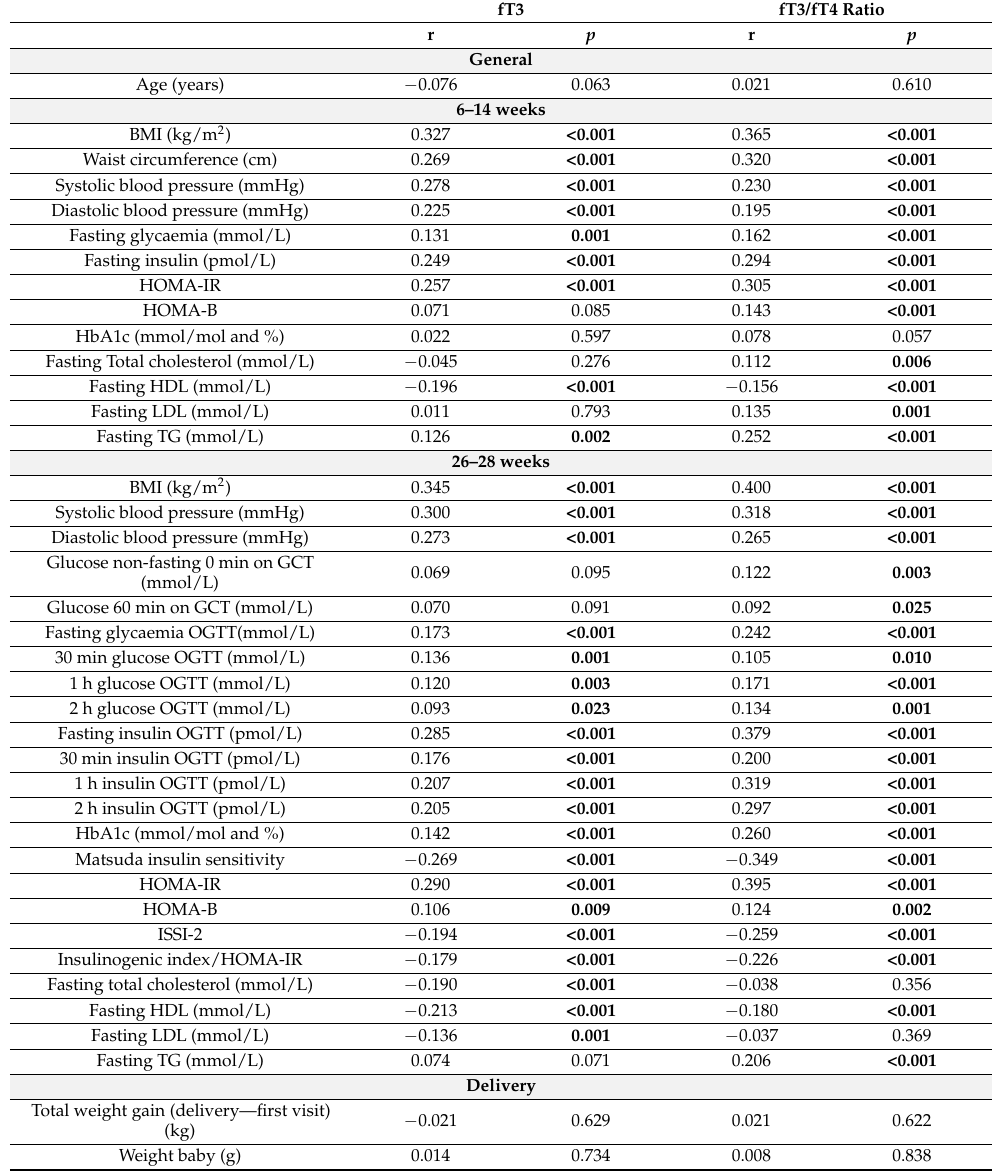
Table 3. Bivariate correlations between maternal thyroid function tests at 26–28 weeks of pregnancy and selected parameters in women with GDM and their matched controls.